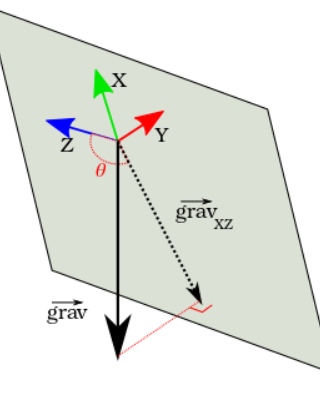
Figure 5. Gravity vector projection into the XZ